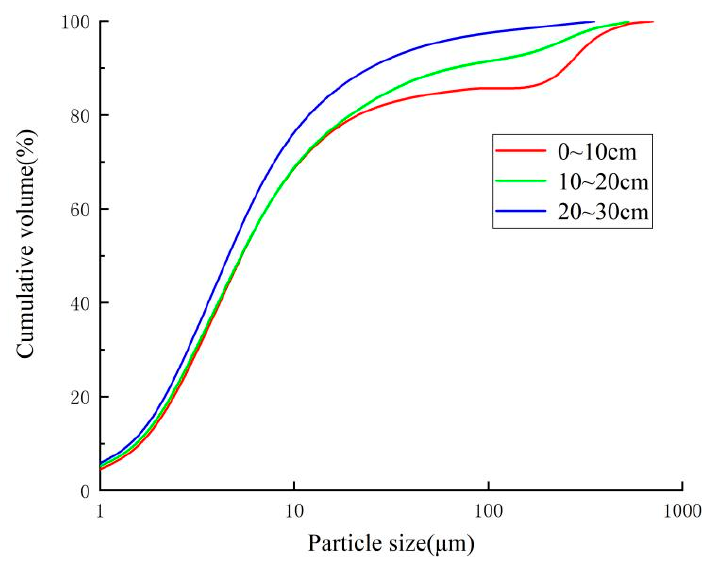
Figure 6. The particle size distribution curves of the sediments at various depths .